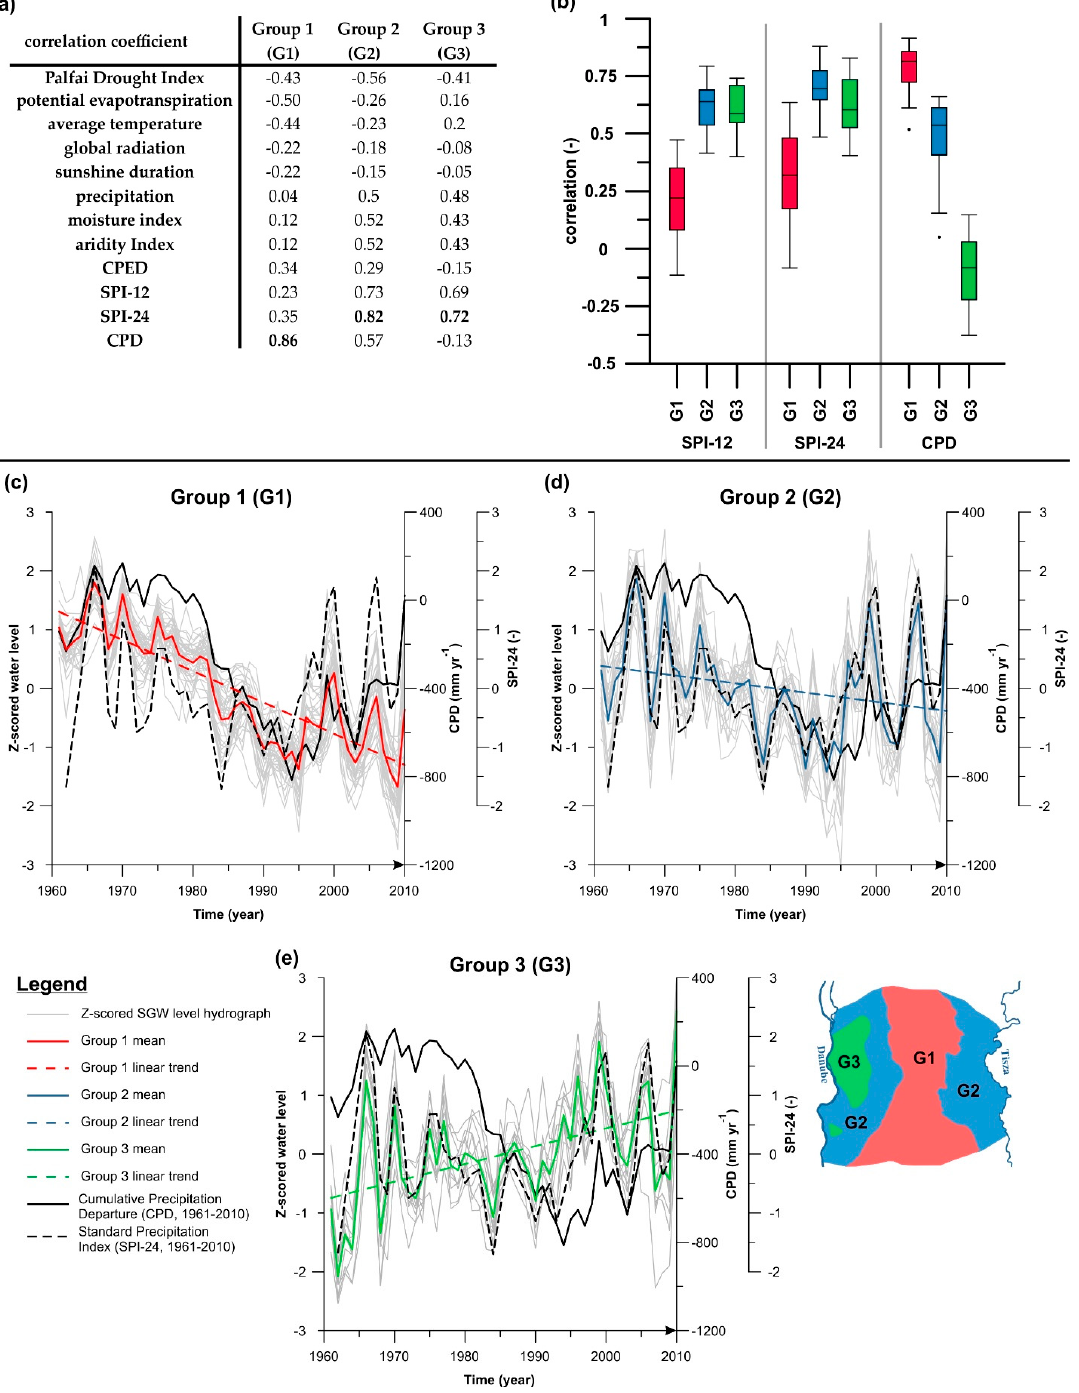
Figure 5. Linear relationships between the SGW level time series and meteorological parameters. Correlation between groups means SGW level time series and the meteorological variables ( a ), where CPED stands for cumulative potential evapotranspiration departure, SPI for the Standardized Precipitation Index (SPI-12, SPI-24), and CPD for cumulative precipitation departure. Correlations falling outside the ±0.279 interval are significant at ∝ = 0.05 . Correlation coefficients of the individual SGW wells and the SPI-12, SPI-24, and CPD indices for each cluster group are shown on box and whiskers plots ( b ). The boxes indicate the interquartile interval, the black line in the middle the